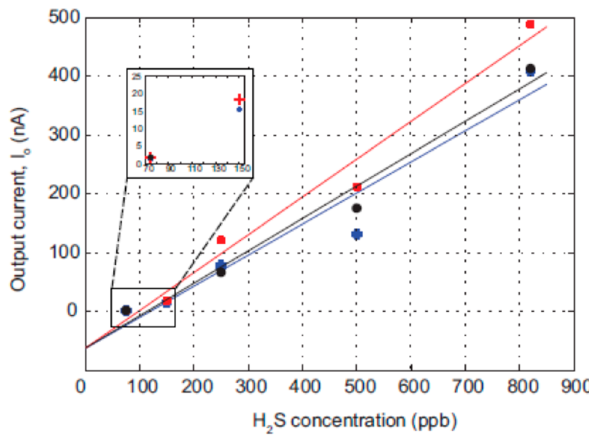
Figure 3. Output current I o as a function of H 2 S concentration. A linear fit to each concentration variation gives the slope, which is then related to the sensitivity of the sensor.